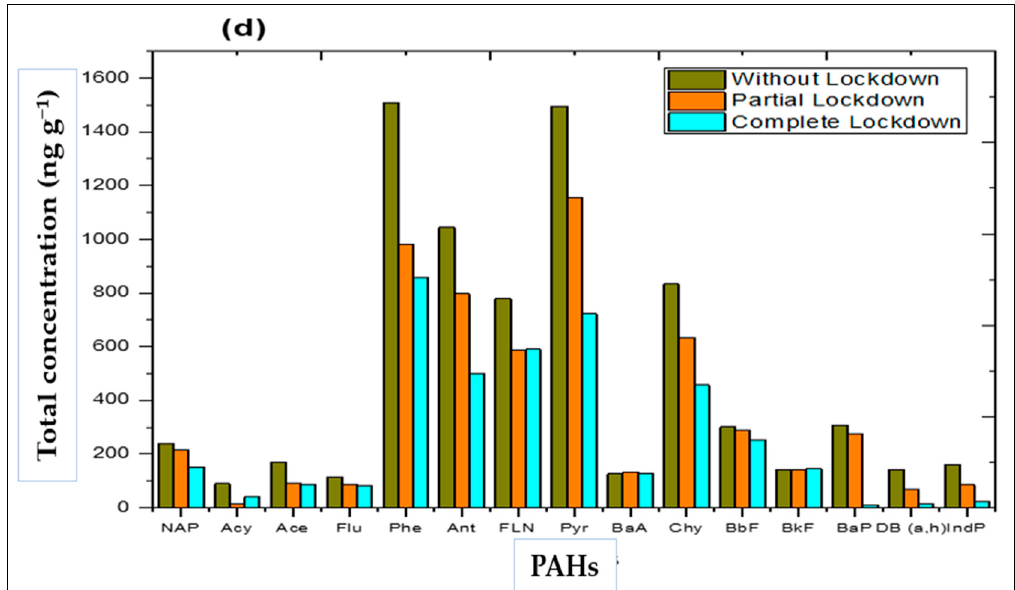
Figure 3. Distribution of different PAHs in different land use categories of street dust during: ( a ) without lockdown, ( b ) partial lockdown, and ( c ) complete lockdown, and ( d ) trends of total individual PAH concentration across the entire lockdown. The bars represent standard deviation from triplicate analysis.